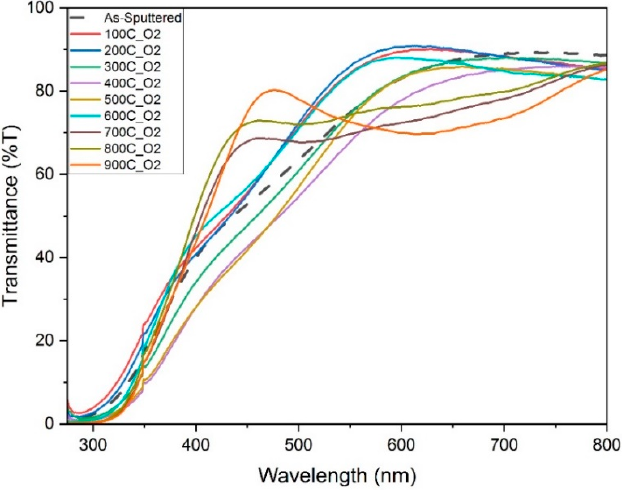
Figure 3. Optical transmission spectra of the Cu 2 In 2 O 5 thin films annealed at various temperatures.